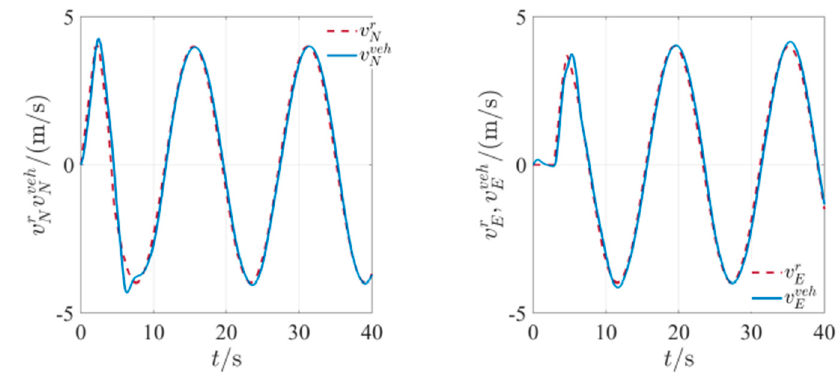
Figure 27. Height diagram of circular tracking.